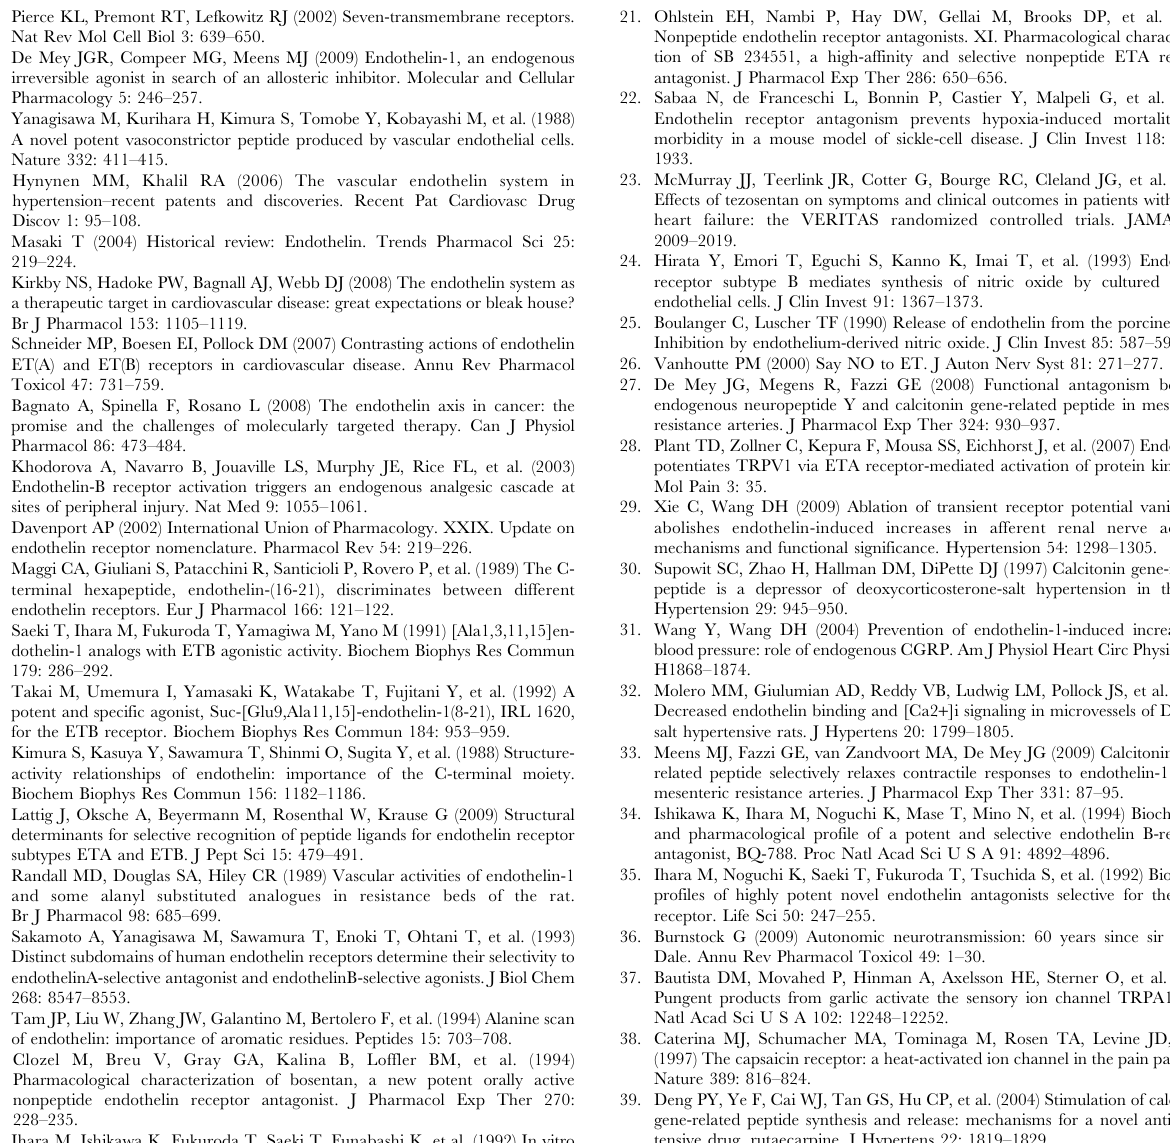
Figure S2 Effects of CGRP and rutaecarpine are endothelium- independent. Isolated, denuded rat arteries were studied in presence of L-NAME (100 m M) and indomethacin (10 m M) as indicated. Arteries were precontracted with 16 nM ET-1.